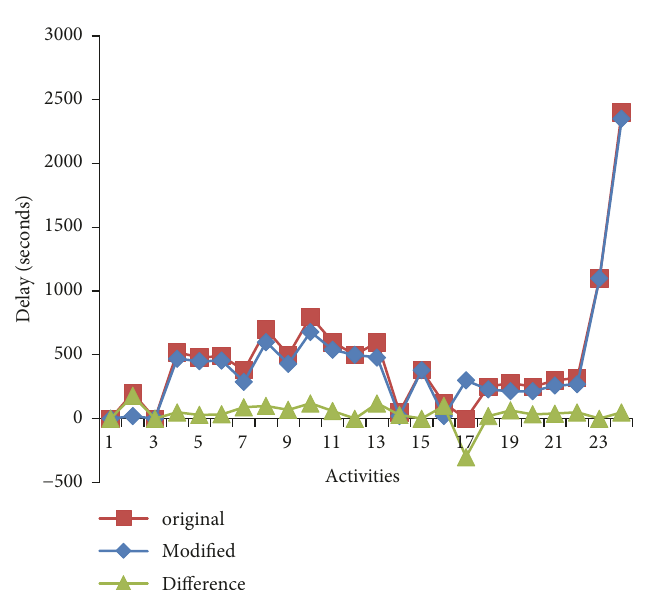
Figure 9: Delays at conflict